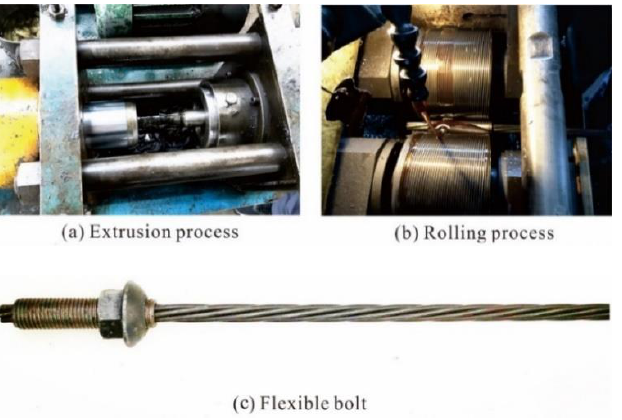
Figure 2. Processing course of flexible bolt: ( a ) extrusion process, ( b ) rolling process, ( c ) flexible bolt.